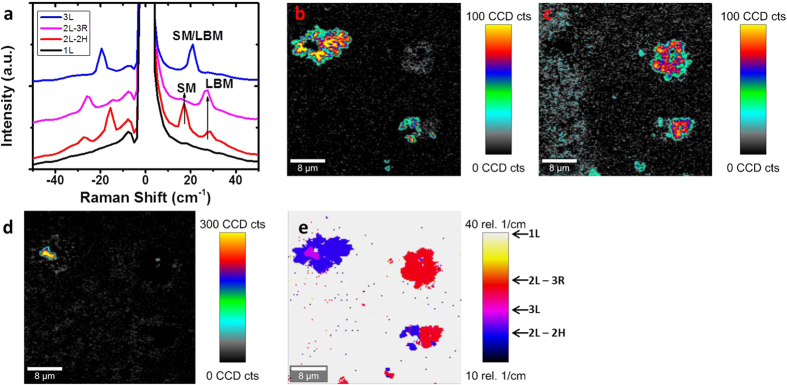
(a) Low-frequency Raman spectra of SMs and LBMs of 1, 2 and 3L WSe2. (b) Peak intensity map of SM mode for 2L-2H WSe2 at ~17 cm−1. (c) Peak intensity map for 2L-3R WSe2 at ~27 cm−1. (d) Peak intensity map of SM/LBM mode for 3L-2H WSe2 at ~21 cm−1. (e) Map of position of maximum peak intensity of the low-frequency Raman modes in the range of 10–40 cm−1.